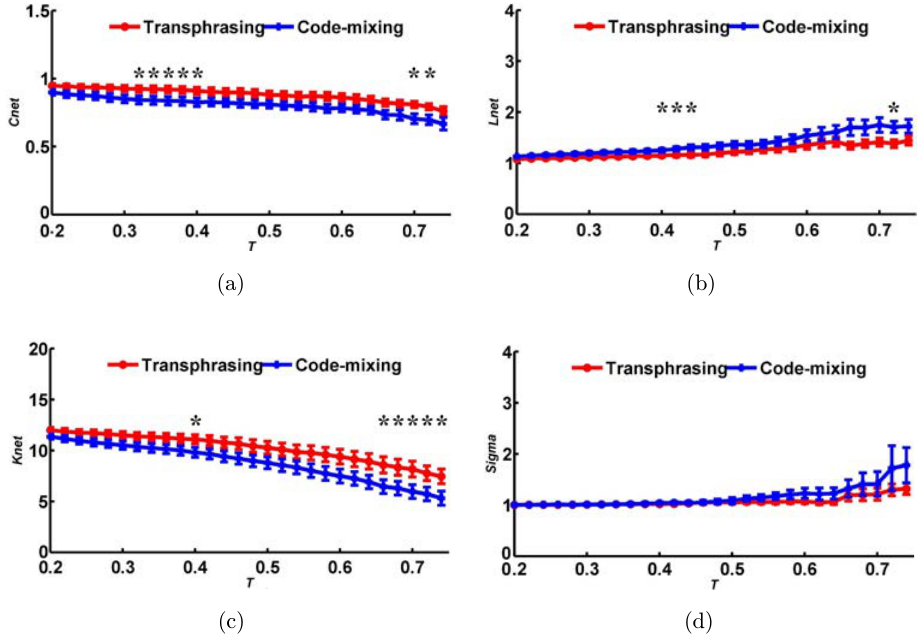
Fig. 6. Comparison of the small-world indicators between the transphrasing and code-mixing translation strategy with absolute thresholding: (a) the clustering coe±cient, (b) average path length, (c) average node degree and (d) measure of small-worldness. The curves ð mean (cid:3) SE Þ show the network indicators with di®erent thresholds, in which the red and blue color represent the trans- phrasing and code-mixing strategy respectively. The horizontal axes denote the threshold values whereas the vertical axes denote the network property